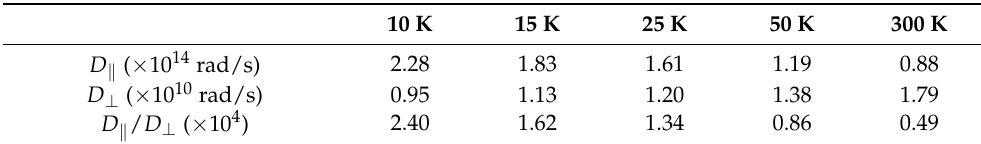
Table 2. The diffusion rates for regio-regular P3HT–ZnO nanoparticles at several temperatures with light irradiation obtained in this